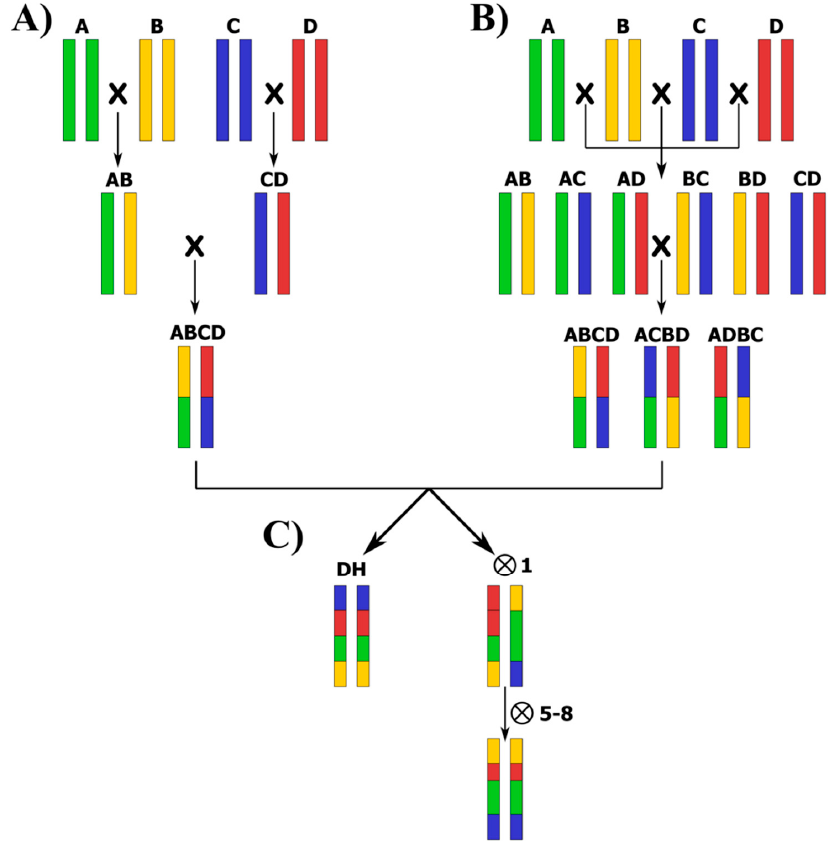
Figure 3. Cross-designs of a 4-way MAGIC population where the founders are A, B, C, and D: ( A ) “funnel” design; ( B ) “diallel” design; and ( C ) achievement of homozygous individuals by doubled (SSD)